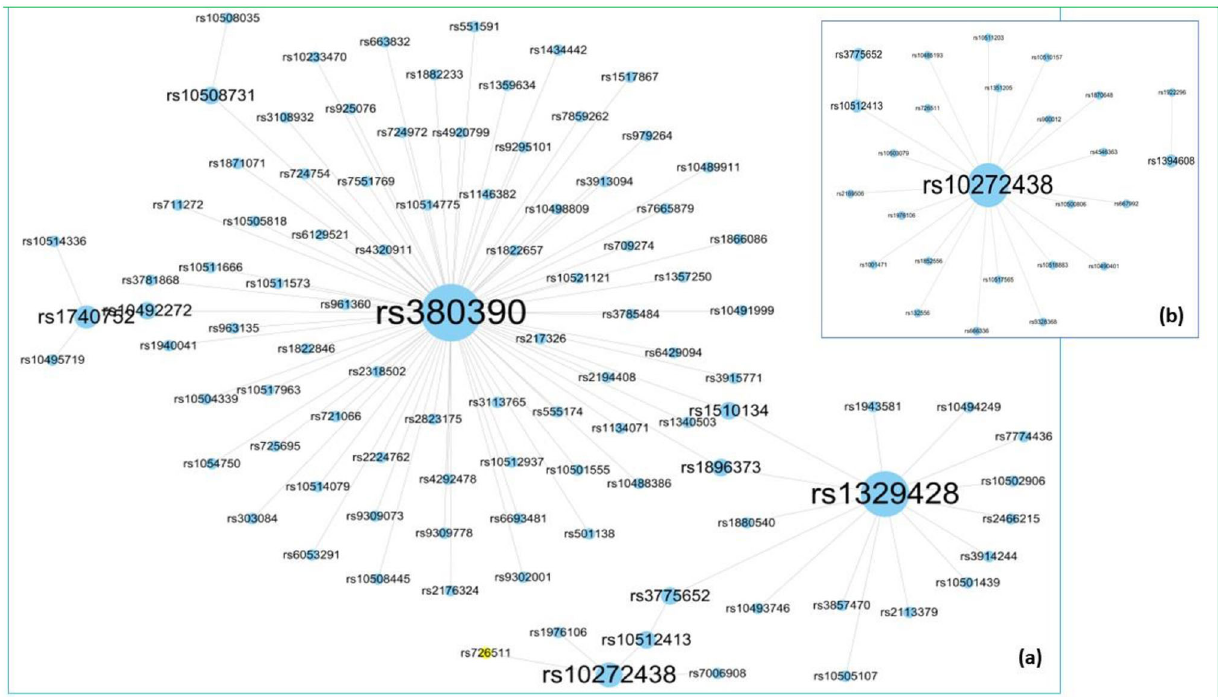
Fig. 10 A 2nd- order SNP interaction network. A node denotes a SNP locus, and an edge indicates that the 2nd- order SNP combination con- nected by that edge is strongly associated with AMD (the significance